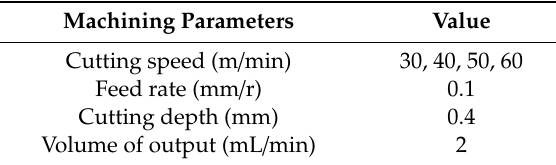
Table 4. Experimental